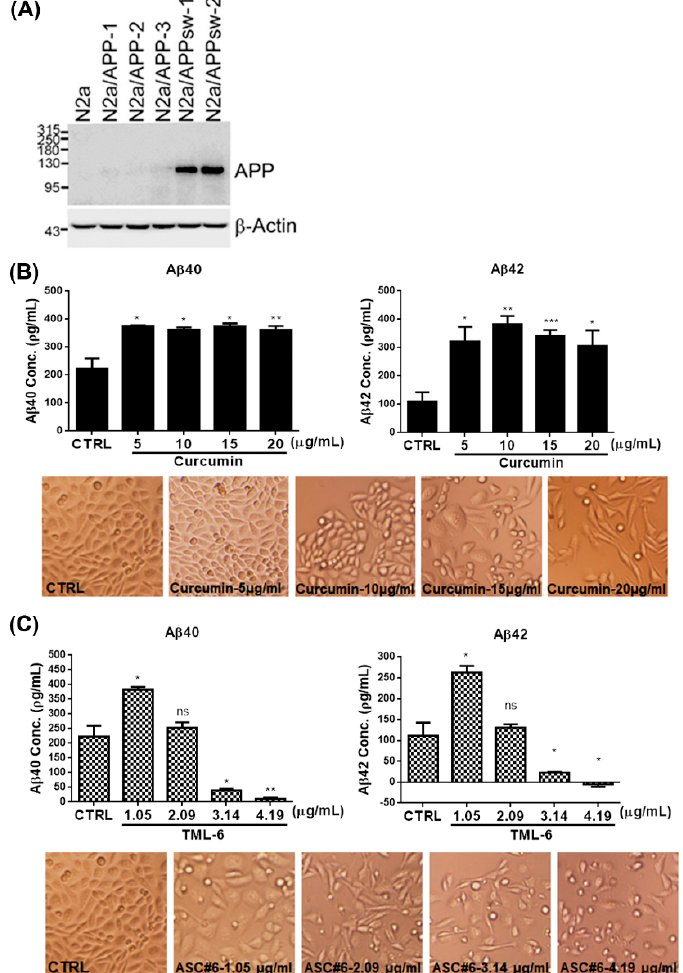
Figure 3. TML-6 suppresses A β production in the N2a / APPswe stable cell line. ( A ) The N2a cell line showed stable over-expression of APP with wild-type full-length (N2a / APP) and Swedish mutant (N2a / APPswe) cells by Western blotting. The N2a / APPswe stable cell line was used to examine A β 40 and A β 42 levels in culture medium in response to traditional curcumin and TML-6 by ELISA test. N2a / APPswe stable cells were treated with di ff erent doses of traditional curcumin ( B ) and TML-6 ( C ) as indicated in the figures. The cell morphological change or viability in each treatment was captured and represented for comparison at the lower panel, as indicated. After 24 h incubation, the culture medium was examined for levels of A β 40 and A β 42 by LEGEND MAX ™ β -Amyloid X-40 and X-42 ELISA Kit. The significant di ff erences between the treated and control cells are represented as the mean with a standard deviation (SD) error bar, and p value < 0.05 was considered significant (* p < 0.05, ** p < 0.01, *** p < 0.001). The cell density, viability, and morphological changes by micrographs were similar between curcumin and TML-6, probably due to cytotoxicity at the highest doses of curcumin (20 µ g / mL) and TML-6 (4.19 µ g / mL) in N2a / APPswe stable